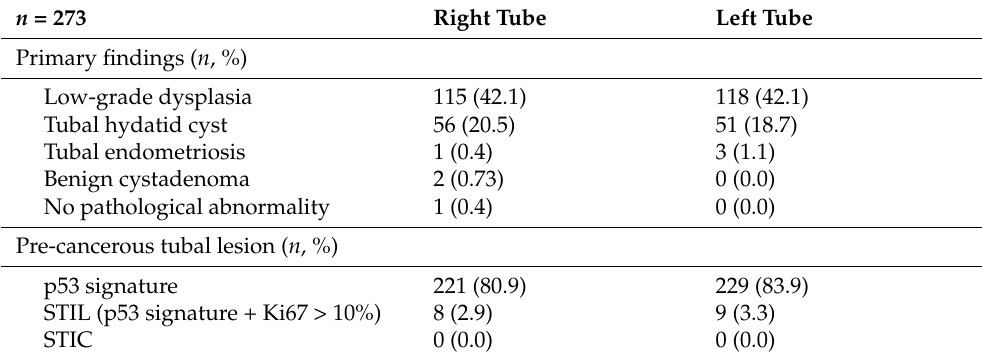
Table 3. Histopathological Results in Fallopian